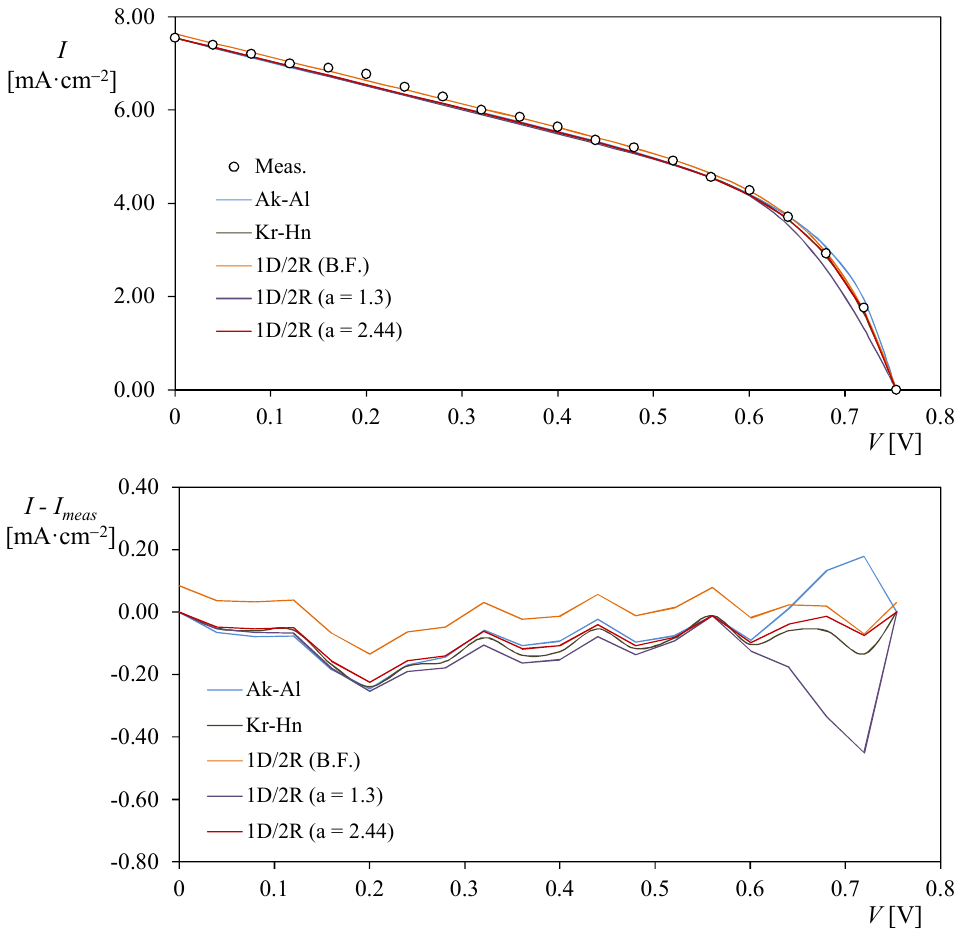
Figure 14. General comparison of the explicit models studied for photovoltaic behavior ( I – V curves). Averaged values of data from Figures 13 and 15.